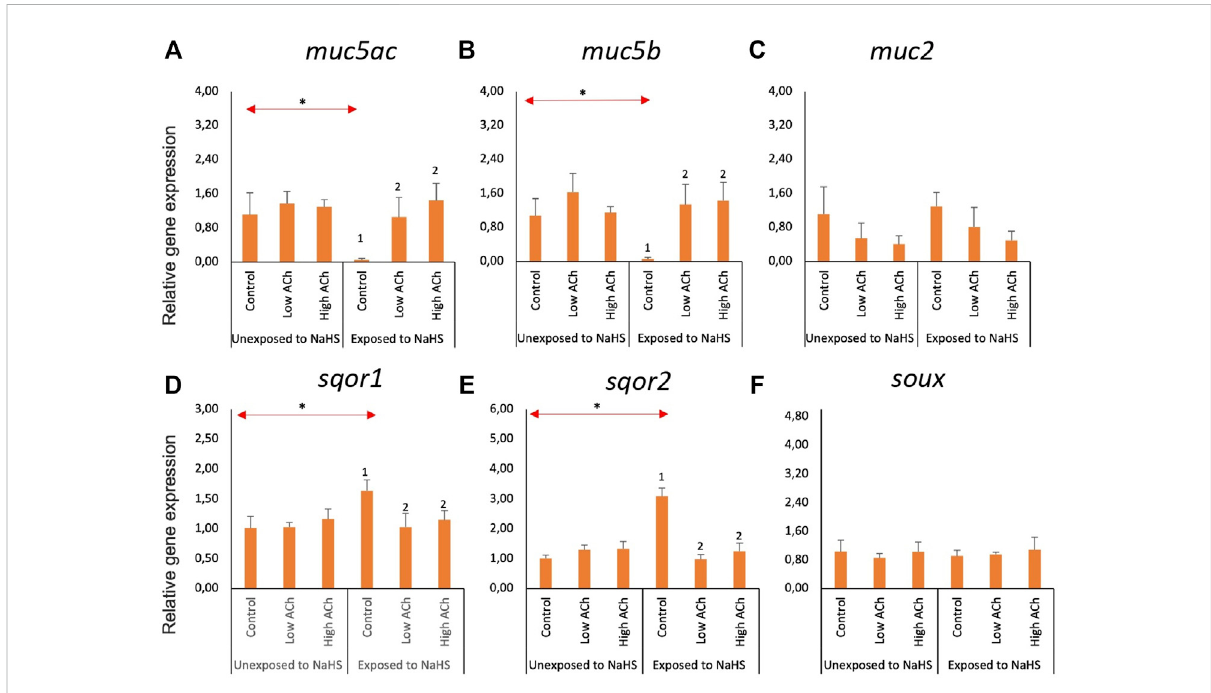
FIGURE 5 Relativegeneexpressionofmucingenes (A – C) andsulphide-detoxi fi cationgenes (D – F) inolfactoryrosetteexplantstreatedwithacetylcholine chloride (Ach) with and without the NaHS exposure. The bars indicate the mean and standard deviation of n = 4. Statistically signi fi cant differences ( p -value < 0.05) within samples unexposed to NaHS are denoted by letters while numeric marks denote the differences within samples exposed to NaHS. Red arrows indicate signi fi cant differences across NaHS exposure ( p -value < 0.05). Please note the differences in the y